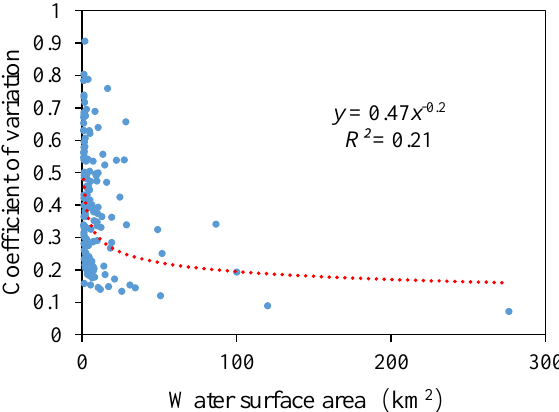
Figure 9. Coefficient of variation (%) of lakes and reservoirs in the Nenjiang River Basin, Northeast China, in relation with their surface areas (km 2 ). The power function presents the numeric relationship between the coefficient of variation (CV) and the water surface area. The Y-axis indicates that the CV shrank 100 times.